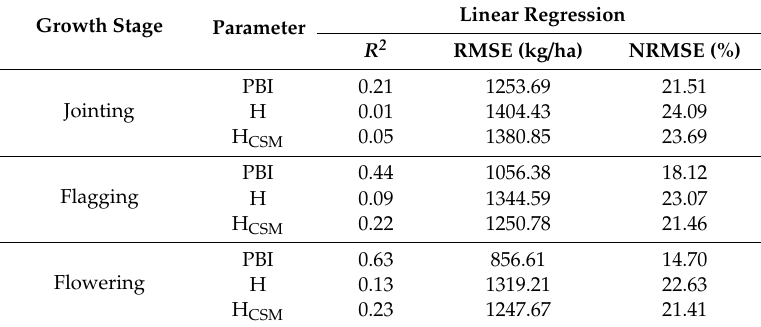
Table 2. The statistical results of yield estimation obtained using the optimal SIs—that is, the plant biochemical index (PBI)—the ground-measured winter-wheat plant height (H), and the winter-wheat plant height extracted from UAV-based hyperspectral images (H CSM ), respectively, for di ff erent growth stages.